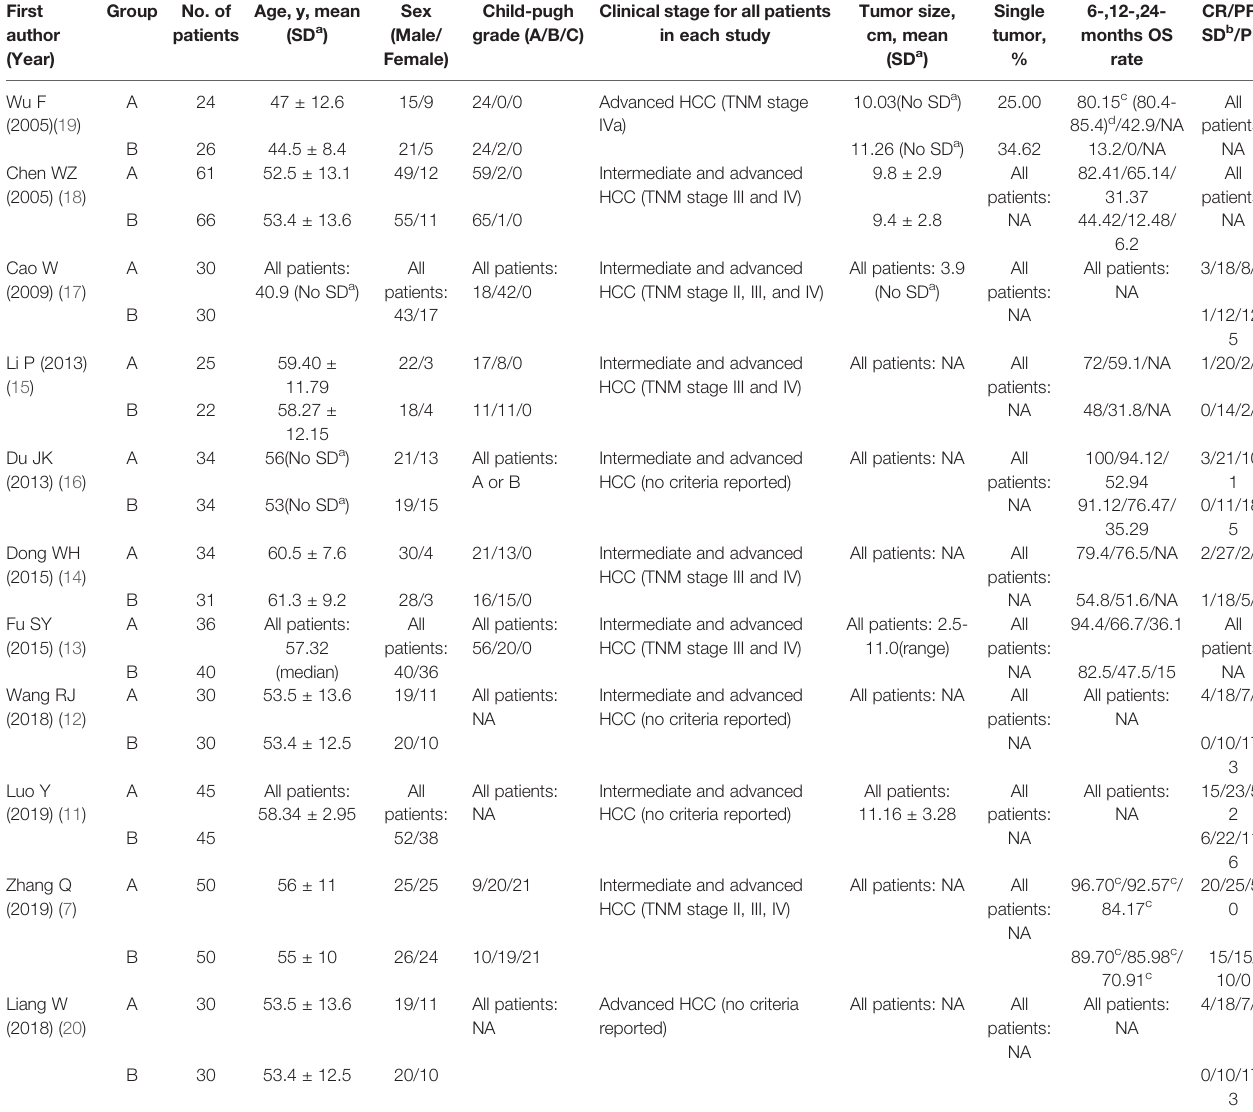
TABLE 1 | Characteristics of the included